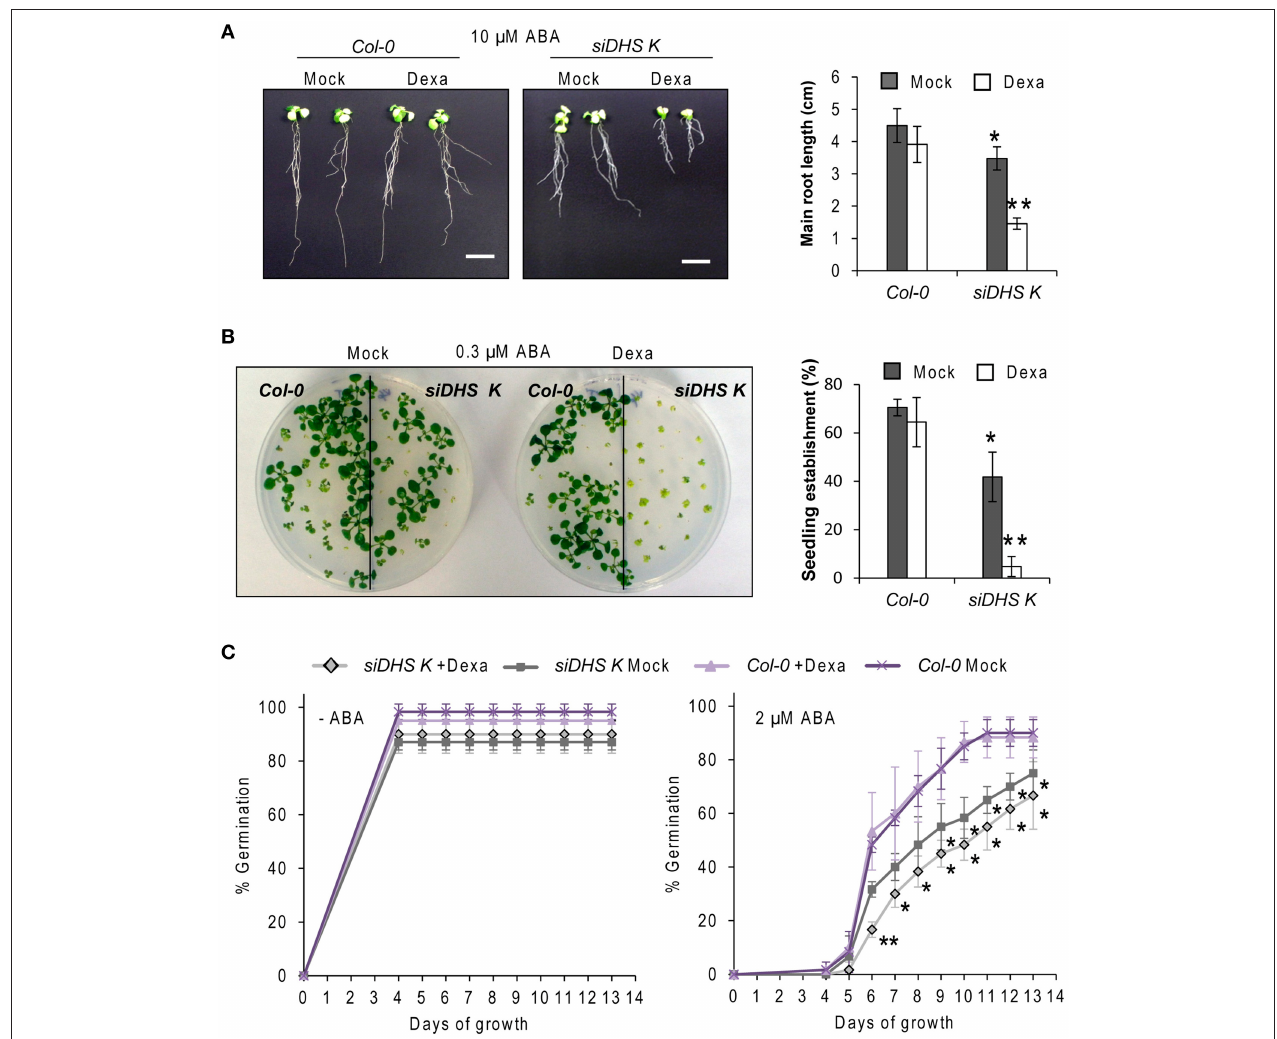
FIGURE 6 | DHS silencing causes hypersensitivity to ABA. (A) 4-day-old wild type and siDHS-K plants grown in vitro under long-day conditions with or without dexamethasone were transferred to medium with 10 µ M ABA for 10 additional days when pictures were taken (left) and the growth of the main root of at least 5 individual plants of each transgenic line and treatment was measured (right). (B) Seedling establishment was estimated by counting wild type and siDHS-K plant seedlings with open healthy leaves after sowing in the absence or in the presence of 0.3 µ M ABA with or without dexamethasone. Left panel shows a representative picture and the statistical quantification with at least 6 individual plants of each genotype and treatment is shown on the right. (C) Germination percentage was determined by counting the number of seedlings able to culminate radicle protrusion after sowing in the absence or in the presence of 2 µ M ABA with or without dexamethasone. The statistical analysis performed in all the cases was one-way anova test. Asterisks indicate significant differences ( p < 0.05 ) with respect to wild type plants (one asterisk) or with respect to wild type plants and mock-treated plants of the same genotype (two